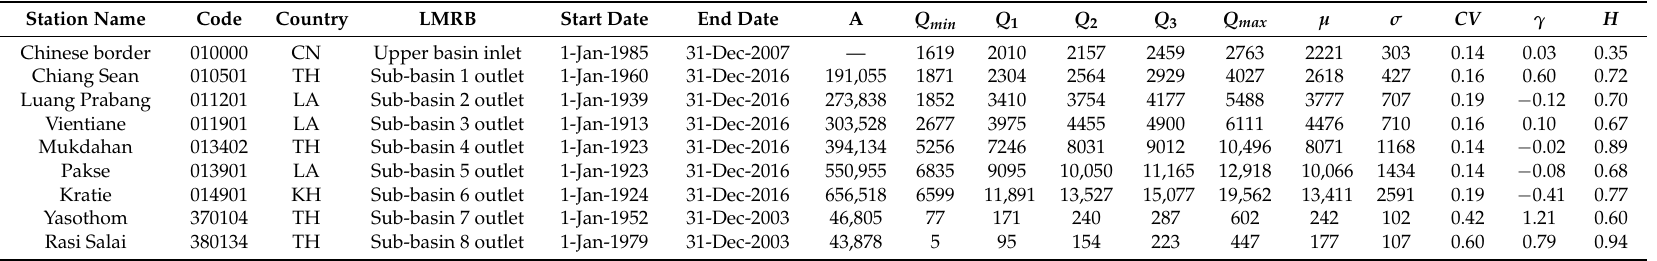
Table 1. The Lower Mekong River annual discharge statistics. Discharge units are in m 3 /s. Country codes are: CN (China), TH (Thailand), LA (Lao People’s Democratic Republic), and KH (Cambodia). The A column refers to the drainage area in square km. Q min and Q max refer to the minimum and the maximum annual discharge over the record at each site. The Q 1 , Q 2 , and Q 3 refer to the 25th, 50th (median), and 75th percentile of the mean annual discharge at each site. The µ refers to the mean annual discharge over the record, σ is the unbiased standard deviation, CV is the coefficient of variation, γ is the skewness, H is the Hurst coefficient. The coefficient of variation CV is equal to σ / µ